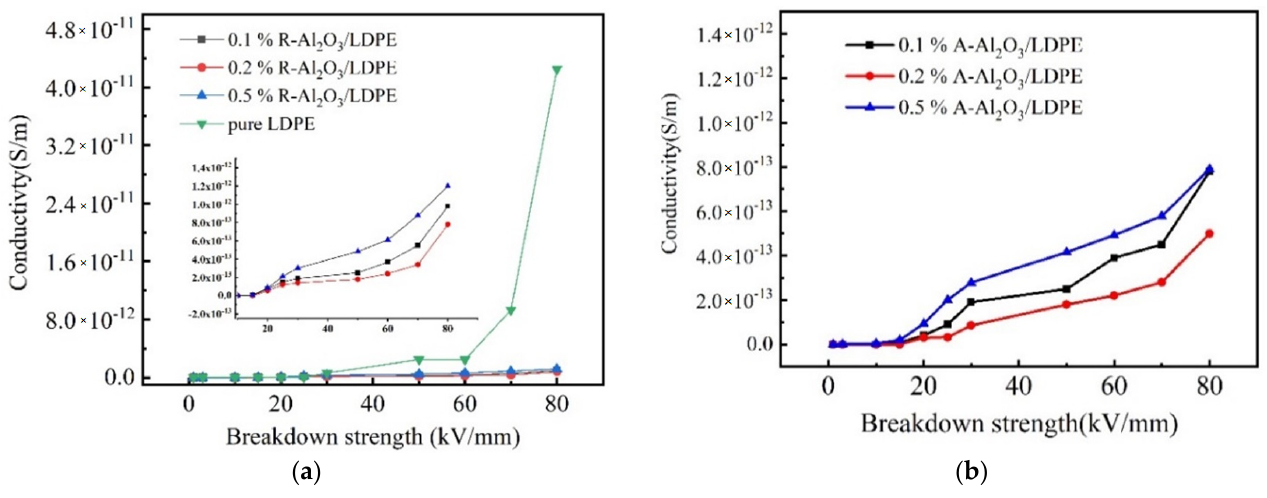
Figure 5. DC conductivity of ( a ) R − Al 2 O 3 /LDPE and pure LDPE, ( b ) A-Al 2 O 3 /LDPE. Compared the DC conductivity of AAl 2 O 3 /LDPE composites, R-Al 2 O 3 /LDPE compo- site, and pure LDPE, the A-Al 2 O 3 /LDPE (0.1%, 0.2%, 0.5%) is significantly lower than that of R-Al 2 O 3 /LDPE with the corresponding contents in the range from 1 kV/mm to